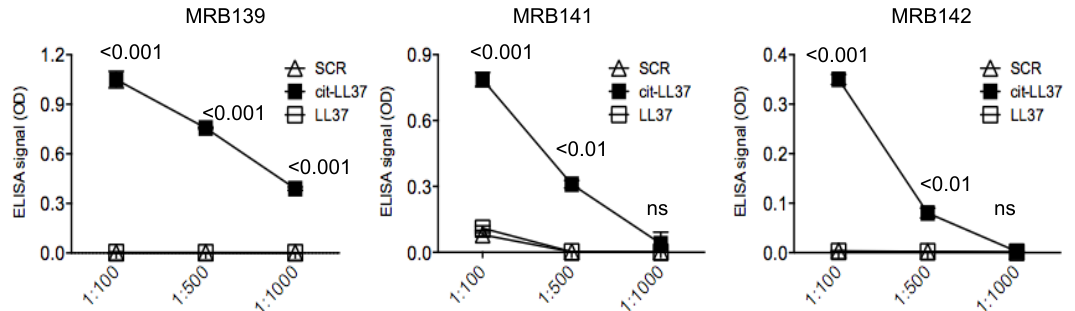
Figure 3. MRB139, MRB141 and MRB142 are specific for cit-LL37. MRB139, MRB141 and MRB142 were diluted in streptavidin ELISA plates coated with biotinylated native LL37 or cit-LL37 or control SCR LL37 peptide at the indicated dilutions and ELISA tests were performed as in Material and Methods. Results are expressed as the mean of triplicate cultures. Standard errors of the mean are indicated. Representative results form three independent experiments. p values by Student’s paired t -test (two-tailed) refer to di ff erence between recognition of cit-LL37 as compared to native LL37 or SCR LL37